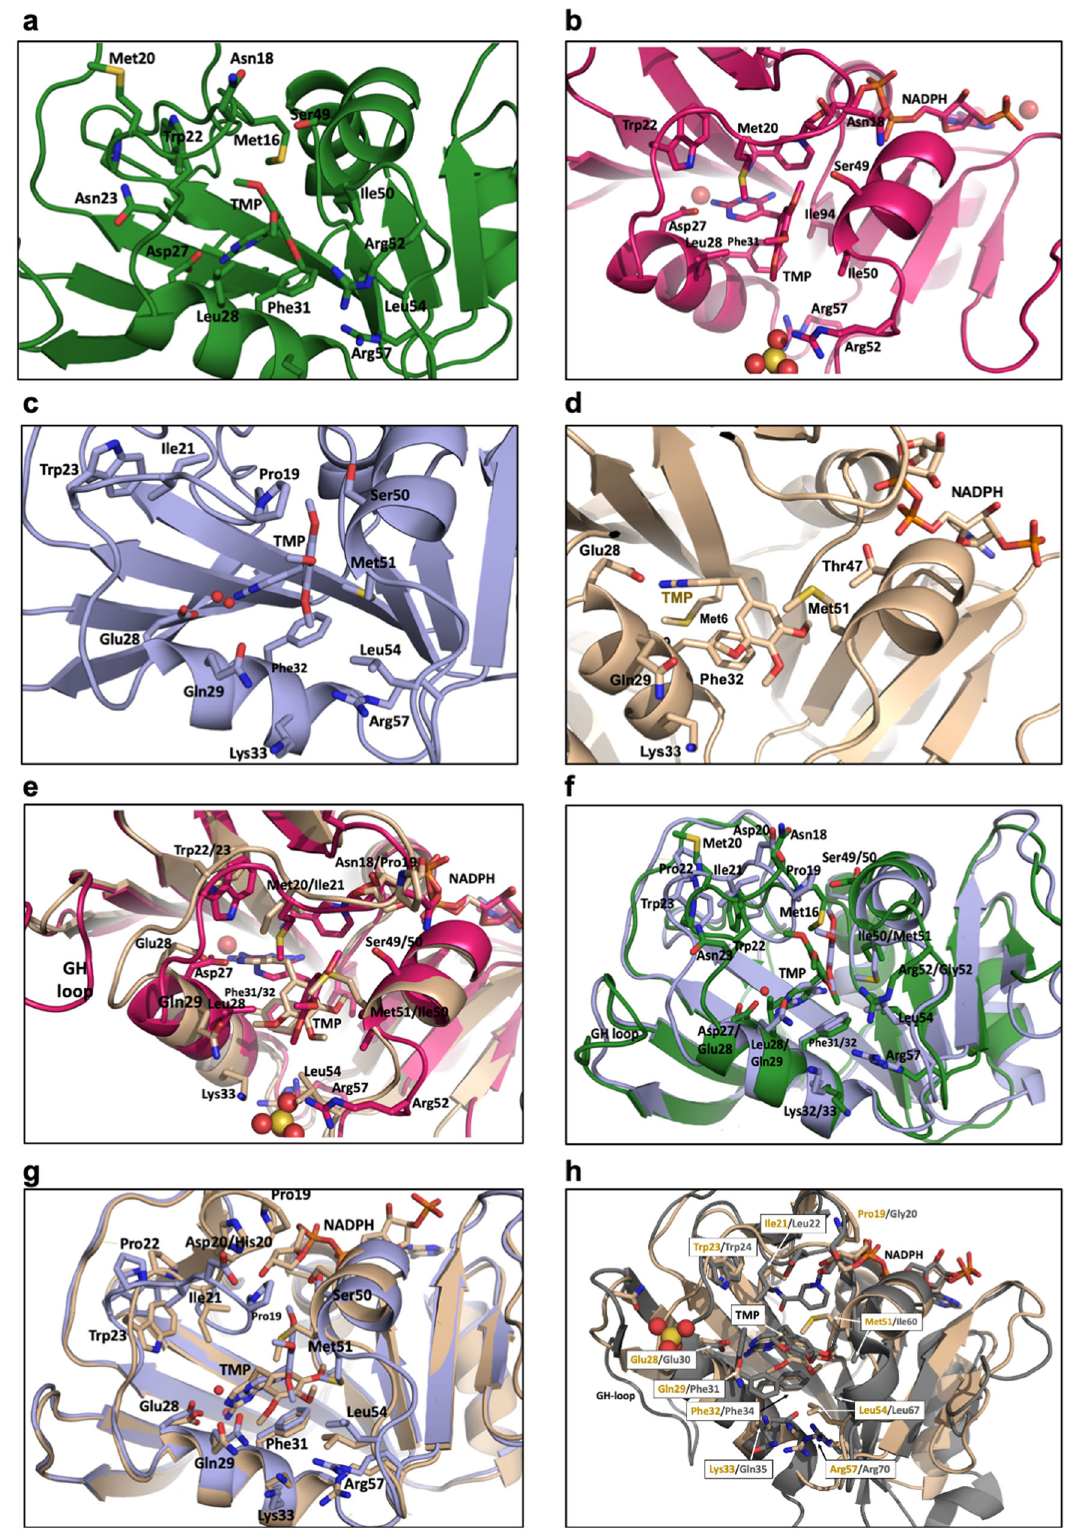
Fig. 3 Crystal structures of DHFR with trimethoprim (TMP). a EcDHFR:TMP (green), b EcDHFR:TMP:NADPH (magenta), c DfrA1:TMP (light blue), and d DfrA5:TMP:NADPH (beige). e Overlays of the crystal structures of DHFR with TMP ternary complexes; EcDHFR:TMP:NADPH (magenta) superimposed onto DfrA5:TMP:NADPH (beige), f Binary complexes; EcDHFR:TMP (green) superimposed onto DfrA1:TMP (light blue), g DfrA1:TMP (light blue) and DfrA5:TMP:NADPH (beige), and h DfrA5:TMP:NADPH (beige) superimposed onto Human DHFR:TMP:NADPH (PDB id code 2W3A). Residues important to ligand binding are shown in stick mode and colored by